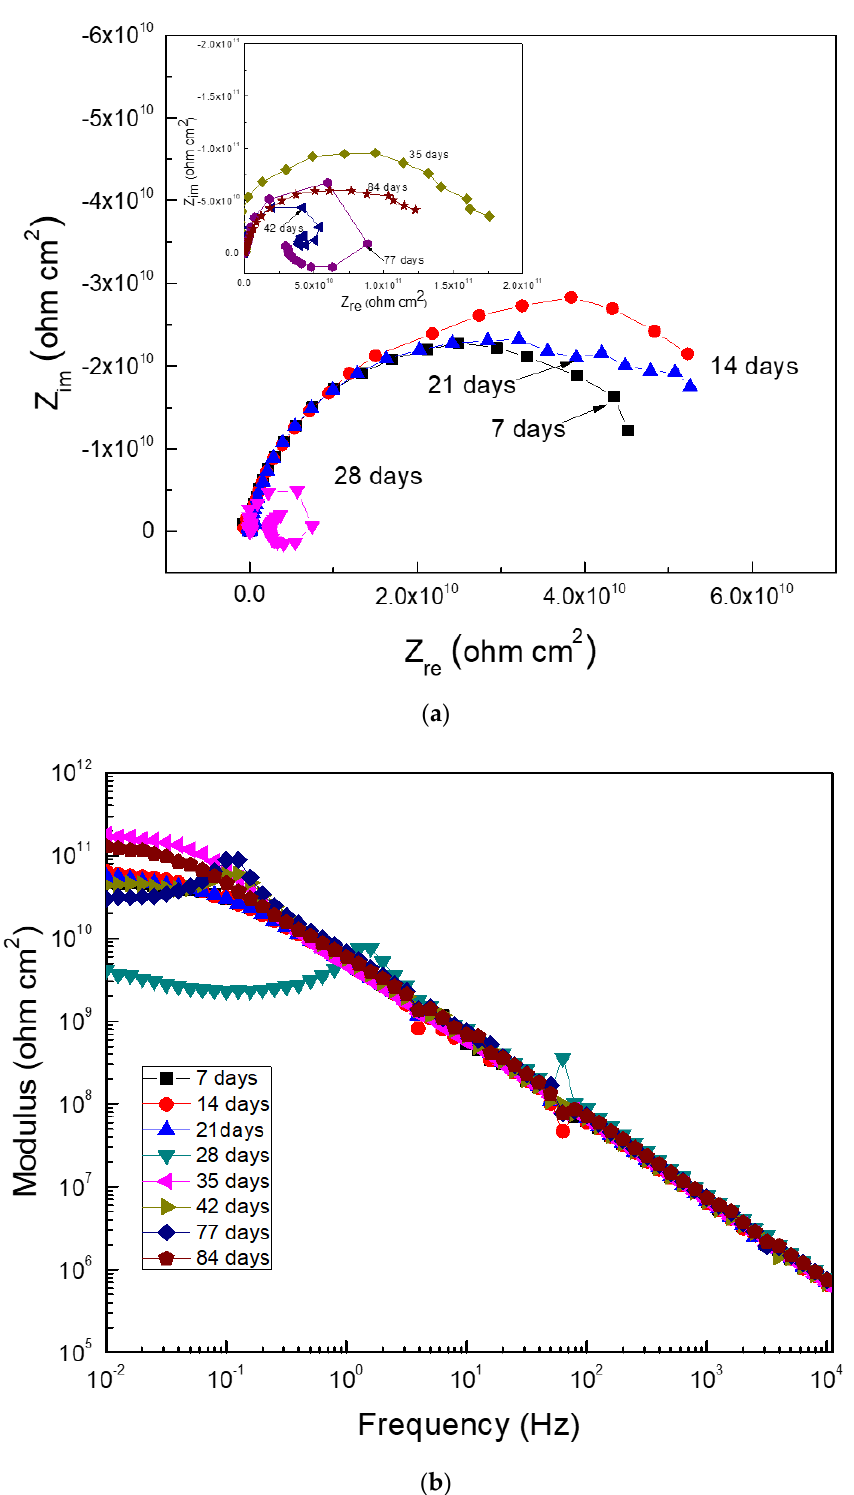
Figure 7. Electrochemical impedance spectroscopy (EIS) data in the ( a ) Nyquist and ( b ) Bode formats for Al in the blend containing ethanol obtained from mangos.